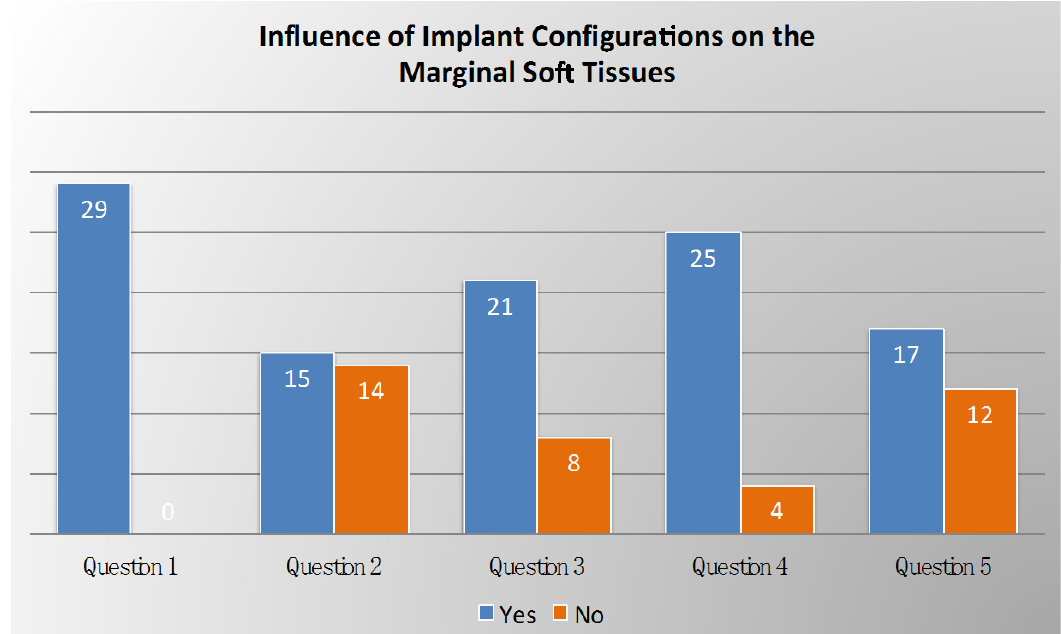
Figure 1. Voting results from the panel of experts regarding the influence of implant configurations on the marginal soft